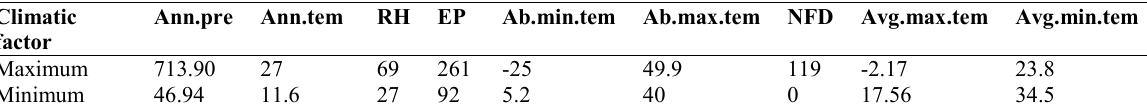
Fig. 3 . Cluster analysis of genotypes based morphological traits by using Ward's method: Abbreviations: C. spinosa Bojnoord ( C. spin Bojn); C. spinosa Chenaran ( C. spin Chen); C. spinosa Boushehr ( C. spin Bosh); C. spinosa Varamin ( C. spin Vara); C. spinosa Kashan ( C. spin Kash); C. spinosa Kermanshah ( C. spin Kerm); C. spinosa Taft (C. spin Taft); C. spinosa Khezrabad (C. spin Khez ); C. spinosa Arsajan (C. spin Arsa ); C. spinosa Sirjan ( C. spin Sirj); C. spinosa Gorgan ( C. spin Gorg); C. spinosa Khoshyeilagh ( C. spin Khos ); C. spinosa Zanjan ( C. spin Zanj); C. spinosa Ashoghlou ( C. spin Asho); C. spinosa Siahroud ( C. spin Siah ); C. spinosa Khoy ( C. spin Khoy). Table 4. Range of climatic factors in C. spinosa population